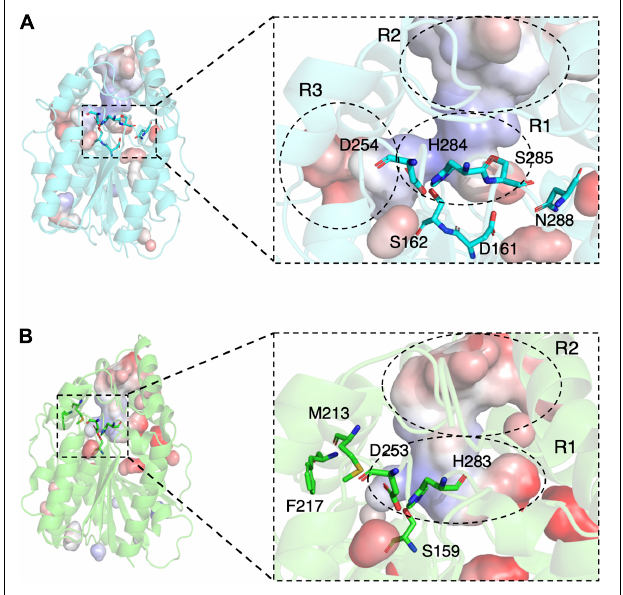
FIGURE 5 | The catalytic pockets of E53 and Est8. (A) The catalytic pocket of E53. The catalytic triad, S162, D254 and H284 were located in the R1 region. The D161, S285 and N288 were targets of mutagenesis in the R1 region. (B) The catalytic pocket of Est8. S159, D253, and H283 were the components of the catalytic triad. The M213 and F217 were mutated in the previous study (Pereira et al.,